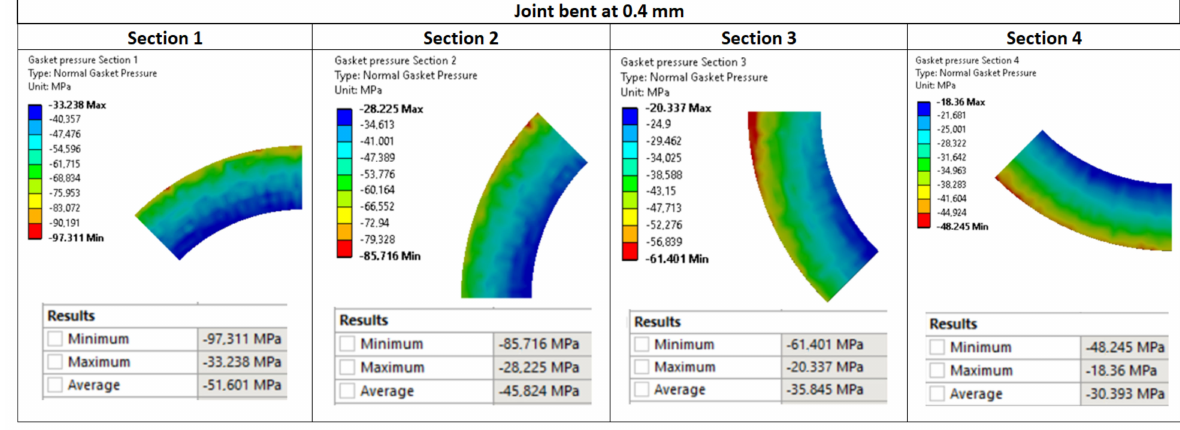
Figure 20. Pressure distribution in the characteristic zones of the gasket—0.4 mm deflection.